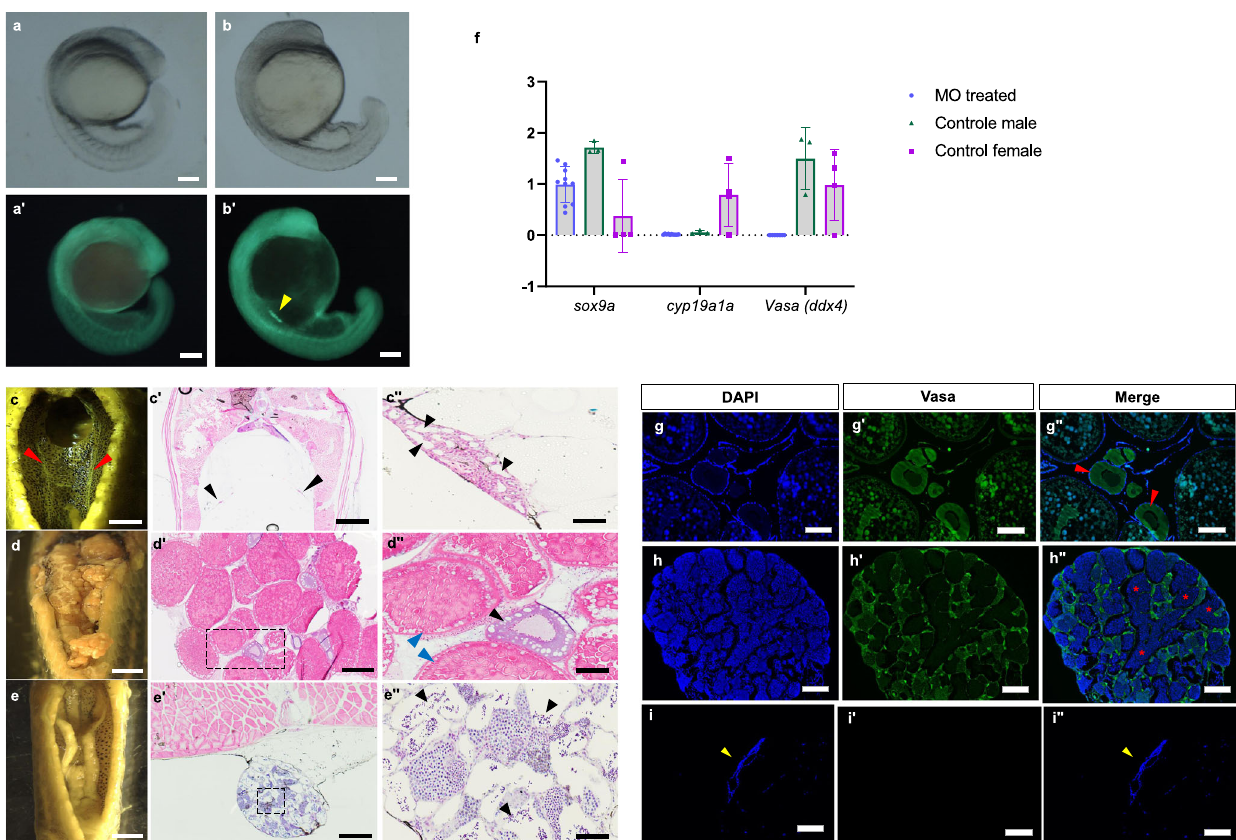
Fig. 2 Dead-end knock-down of giant danio. a , a ’ Embryo injected with MO plus gfpUTRnanos3 during the segmentation period shows no GFP-positive cells, n = 50. b-b ’ PGCs in a positive control injected with gfpUTRnanos3 only shows the presence of a cluster of PGCs under fl uorescence (yellow arrowhead), n = 50, c The midsection of a 1-year-old morphant fi xed with Bouin ’ s shows a pair of underdeveloped gonads, thread-like structures